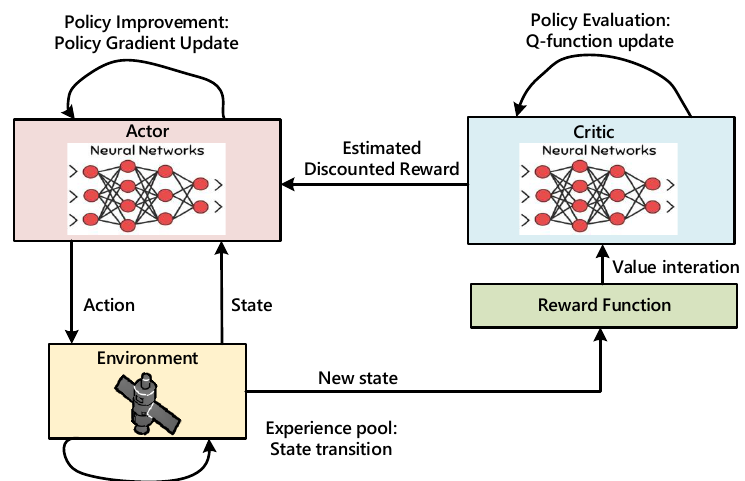
Figure 5. Illustration of DDPG